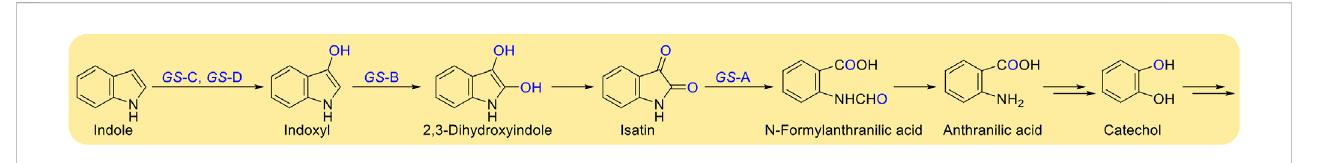
FIGURE 6 Proposed indole biodegradation pathway in Providencia rettgeri